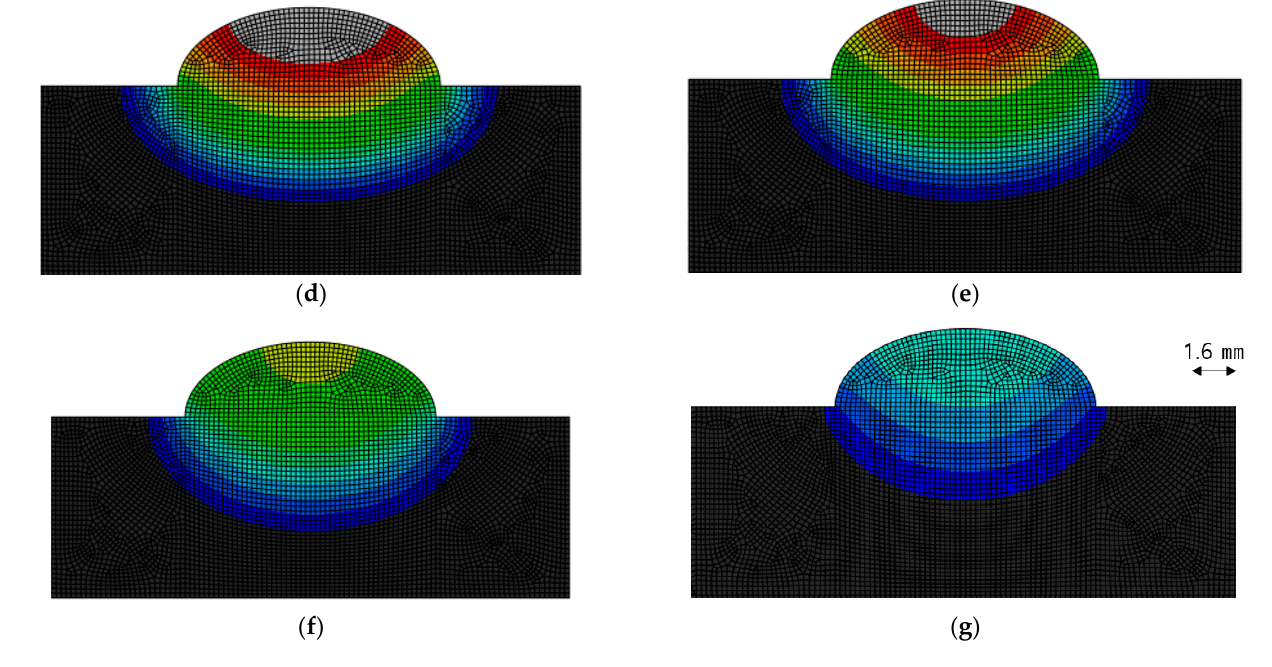
Figure 10. Temperature distribution by timeline before and after welding . Times were ( a ) − 0.5 s (before the heat source arrives); ( b ) − 0.1 s (before the heat source arrives); ( c ) 0 s (when the heat source is directly above); ( d ) 0.5 s elapsed; ( e ) 1.0 s elapsed; ( f ) 2.0 s elapsed; ( g ) 4.0 s elapsed.